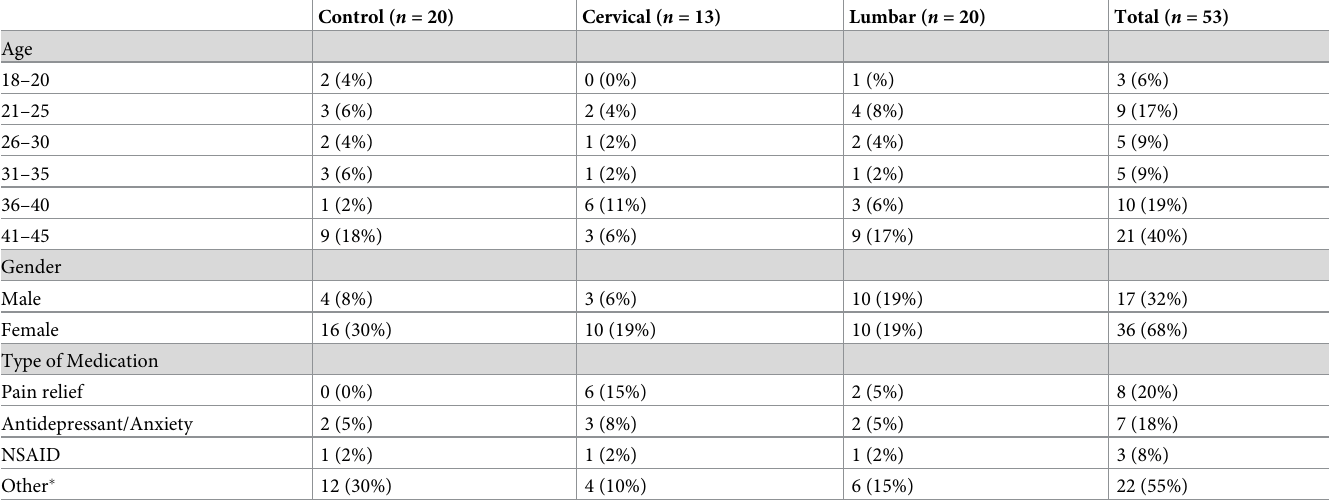
Table 1. Sample characteristics of age, gender and medication